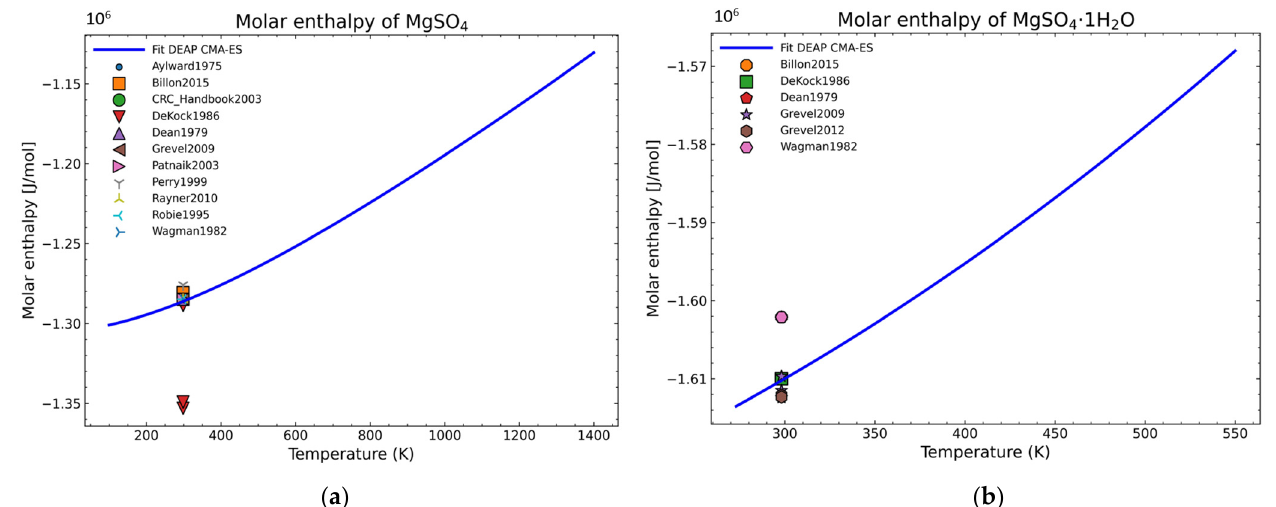
Figure 15. Fitted results of the enthalpy curve in the literature points region for: ( a ) MgSO 4 ; ( b ) MgSO 4 ·1H 2 O.